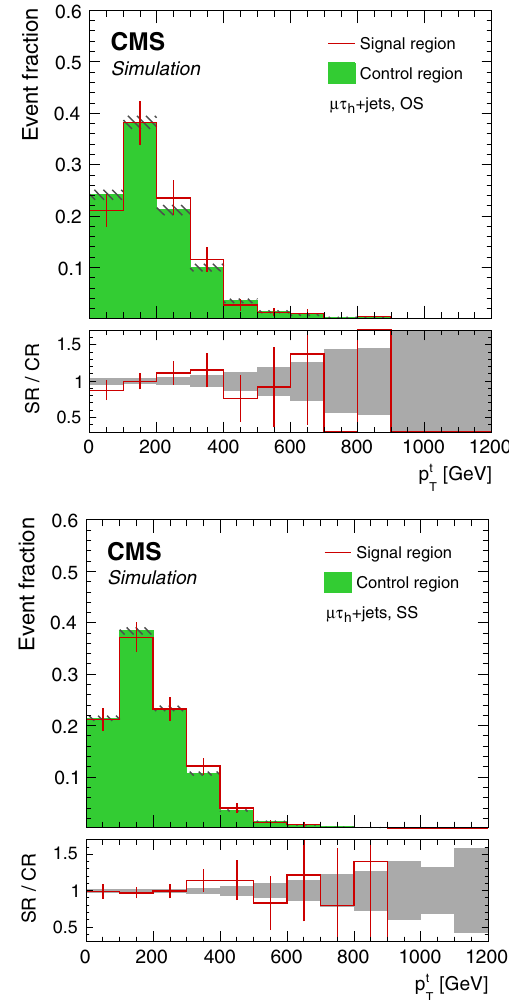
Fig. 2 Shape comparison between the category A signal region and the corresponding control region, as a function of p t , for simulated tt T and W + jets events. Events with an opposite-sign μτ h pair are shown in the upper panel, while those with a same-sign μτ h pair are shown in the lower panel. The full selection is applied and the S T categories are combined. All histograms are normalized to the total number of entries. Uncertainties of the signal region and control region are indicated by red error bars and gray hatched areas, respectively. The gray band in the ratio plot corresponds to the statistical uncertainty in the simulated samples